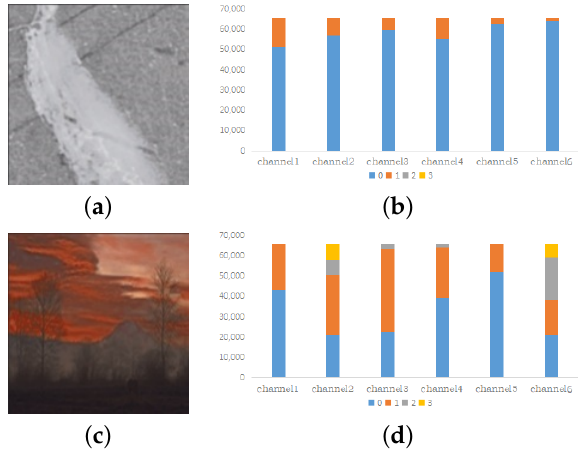
Figure 2. The distribution of halftone data for each channel of tile and landscape images. ( a ) Ce- ramic tile color separation image; ( b ) Ceramic tile color separation image’s data distribution image; ( c ) Landscape; ( d ) Landscape color separation image’s data distribution